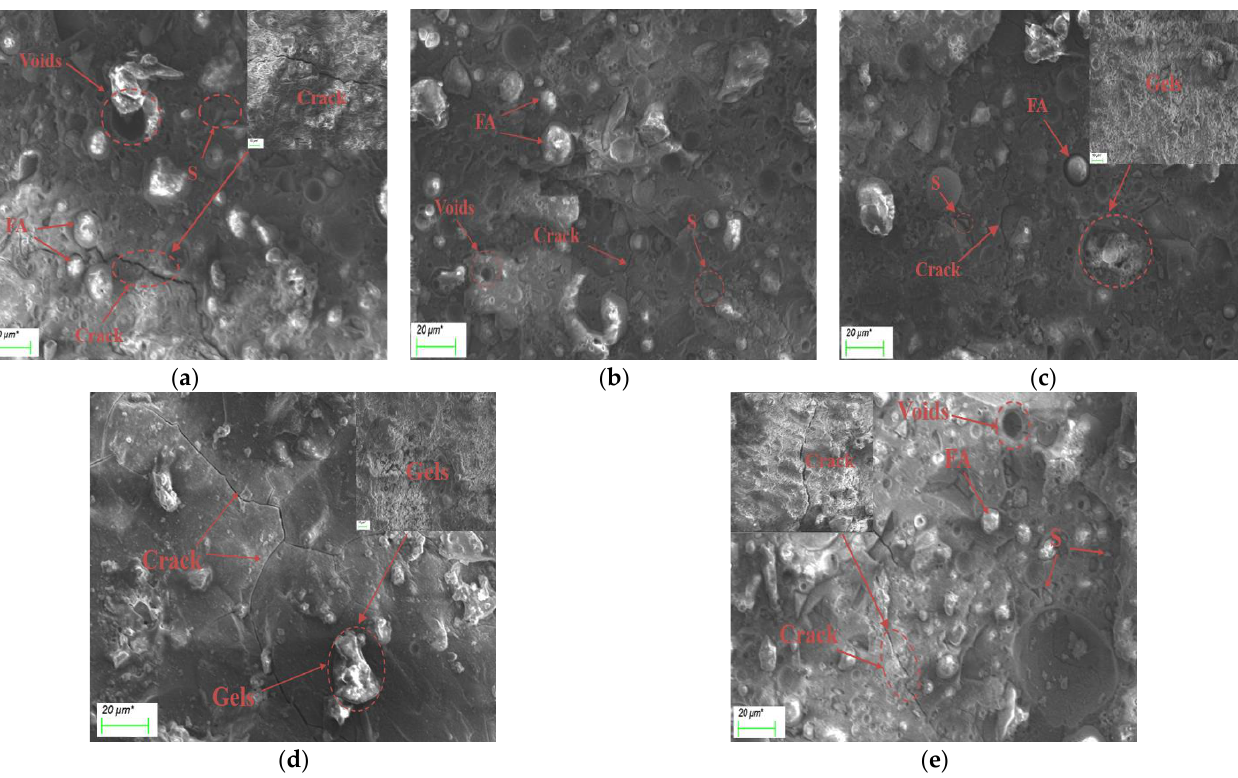
Figure 10. SEM images of alkali-activated composite cementitious materials under different activator concentrations: ( a ) S50C1; ( b ) S50C2; ( c ) S50C3; ( d ) S50C4; ( e ) S50C5. (μm* represents the unit μm)